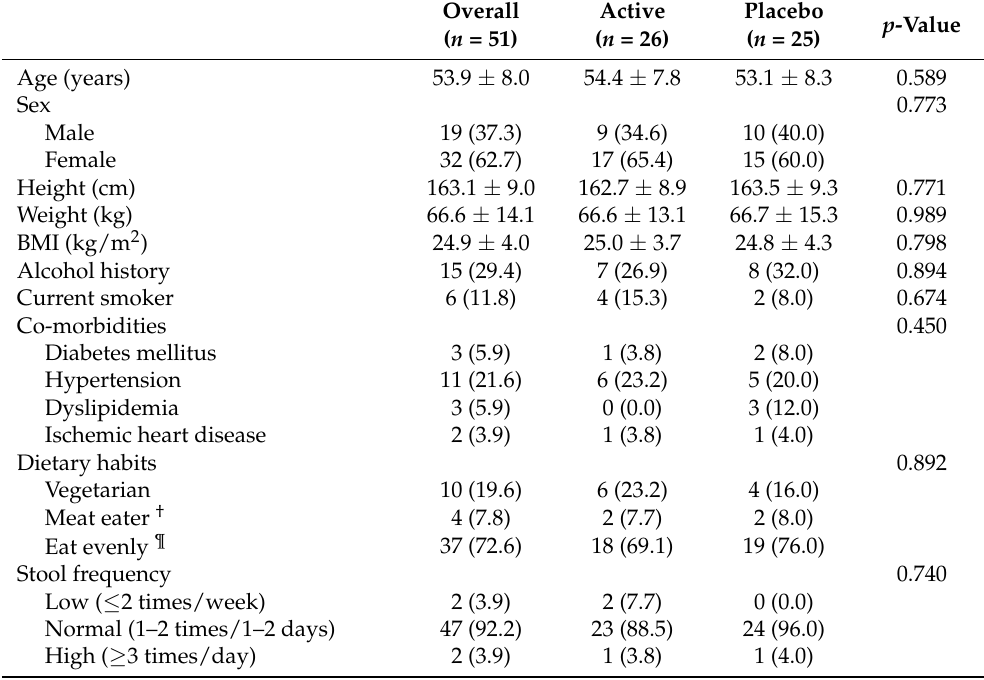
Table 1. Baseline characteristics and colonoscopy